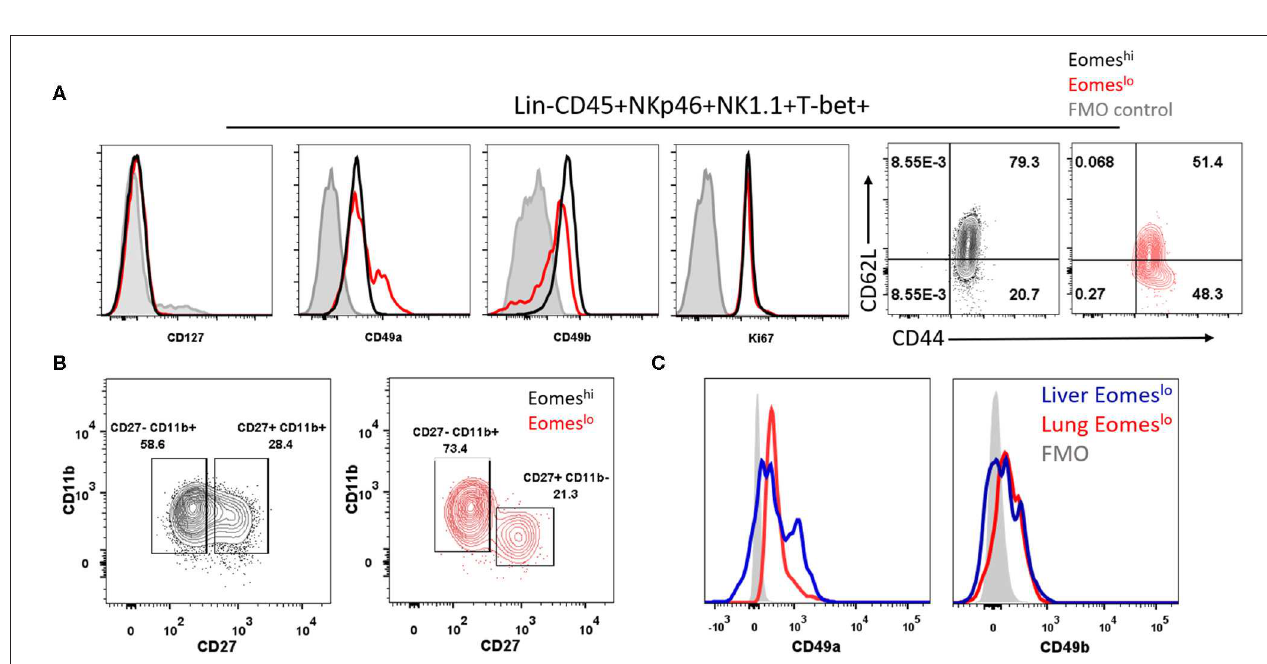
FIGURE 4 | Eomes lo Group 1 ILCs represent both cNK and tr-NK (ILC1) phenotype and function. (A) Representation of CD127, CD49a, CD49b expression in Eomes lo and Eomes hi subsets. Ki67 (proliferation marker) and CD44, CD62L (endothelial cell interaction/recruitment marker) levels on Eomes lo and Eomes hi cells were measured relative to FMO controls; red—Eomes lo , black—Eomes hi , gray—control. (B) Maturation status of NK cells using Cd11b and CD27 markers, with gating based on FMO controls; red—Eomes lo , black—Eomes hi (C) CD49a and CD49b expression levels in lung Eomes lo compared to liver Eomes lo cells relative to FMO (Fluorescence Minus One) controls. MFI is Mean Fluorescence Intensity, n = 4 for each group. Data are representative of three independent repeats.